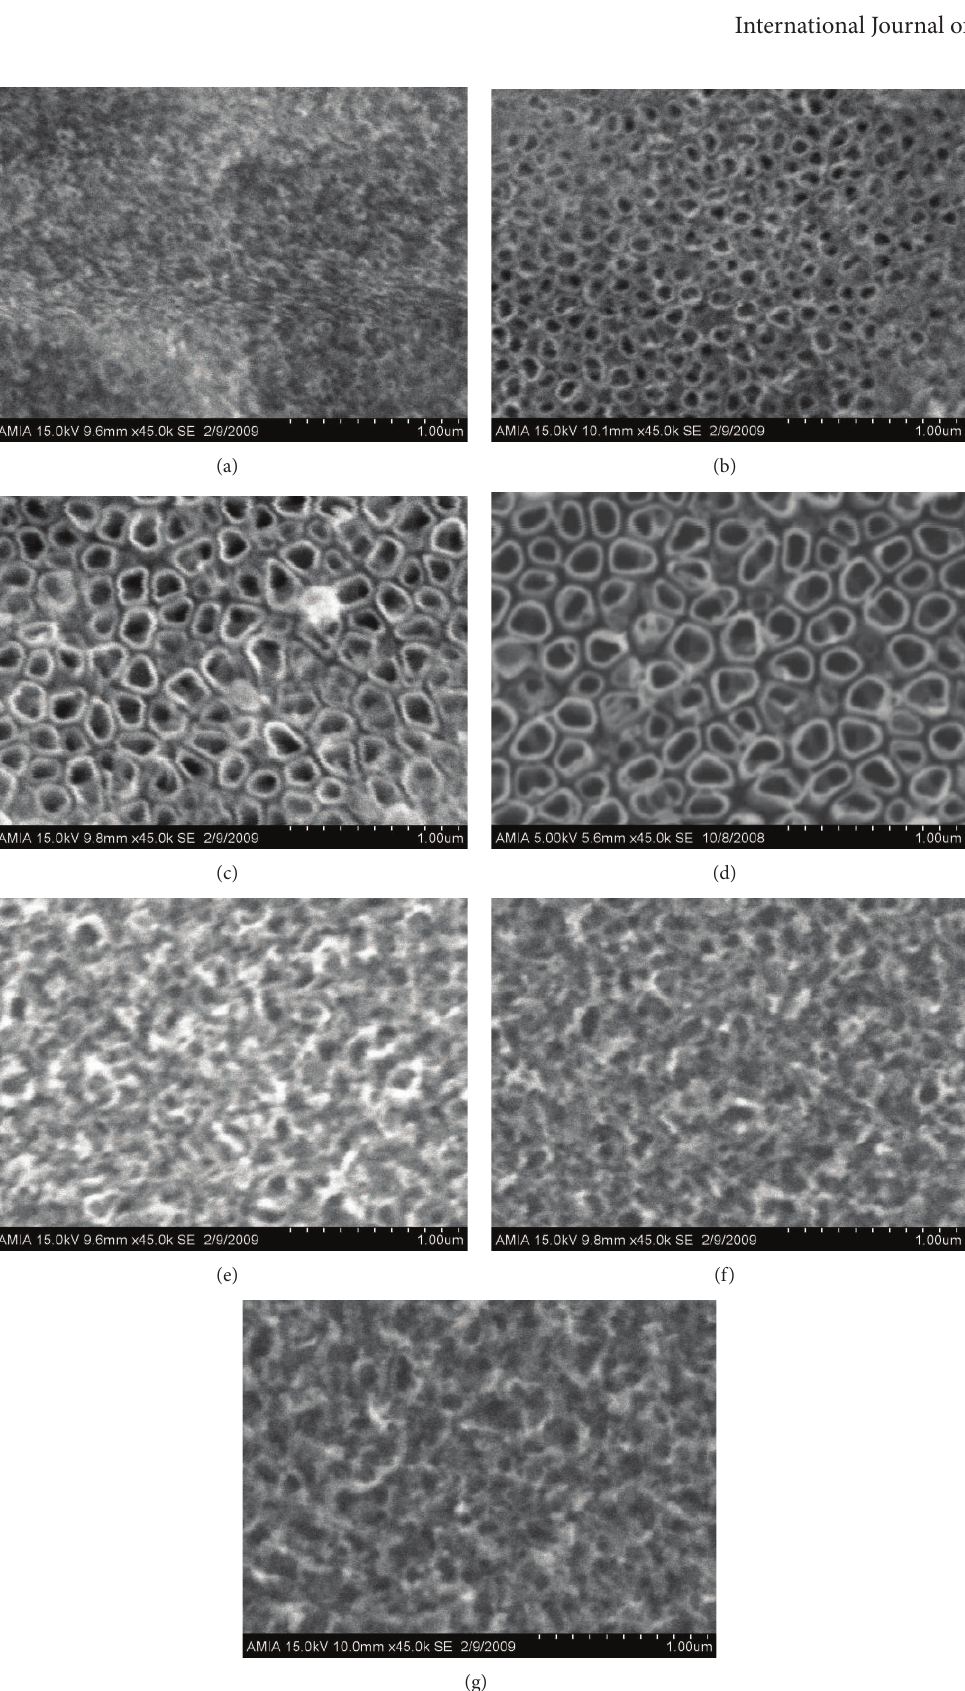
Figure 2: Top view of SEM images of TNT synthesized at different anodization voltages: (a) 10V, (b) 20V, (c) 30V, (d) 40 V, (e) 50 V, (f) 60V, and (g) 70